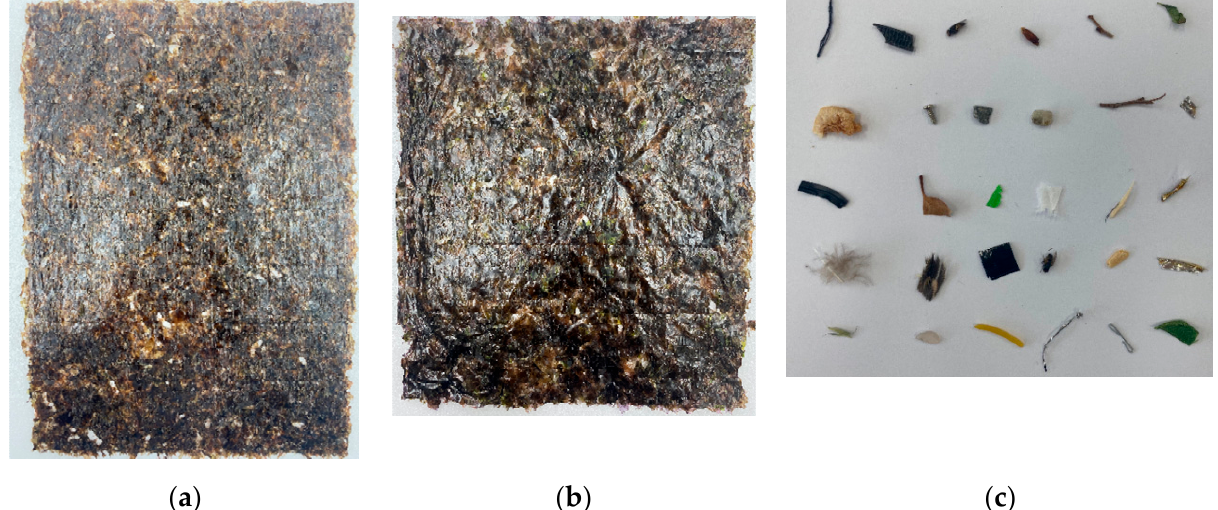
Figure 1. Seaweed used in the experiment. ( a ) Obtained from the real manufacturing site (Rectangular-shaped), ( b ) Commercial products (square-shaped) ( c ) Examples of foreign objects.